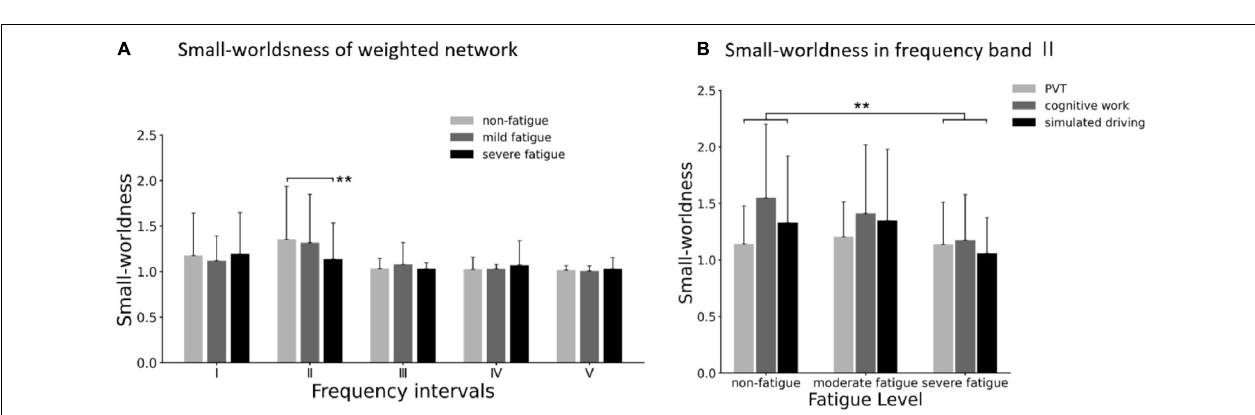
FIGURE 10 | (A) Comparison of clustering coefficient of three fatigue levels in five frequency bands. (B) Results of post-hoc analyses of clustering coefficient in frequency band III (0.052–0.14 5 Hz). (C) Comparison of characteristic path length of three fatigue levels in five frequency bands. (D) Results of post-hoc analyses of characteristic path length in frequency band III (0.052–0.145 Hz). Vertical bars are standard errors scores. ** p < 0.01.